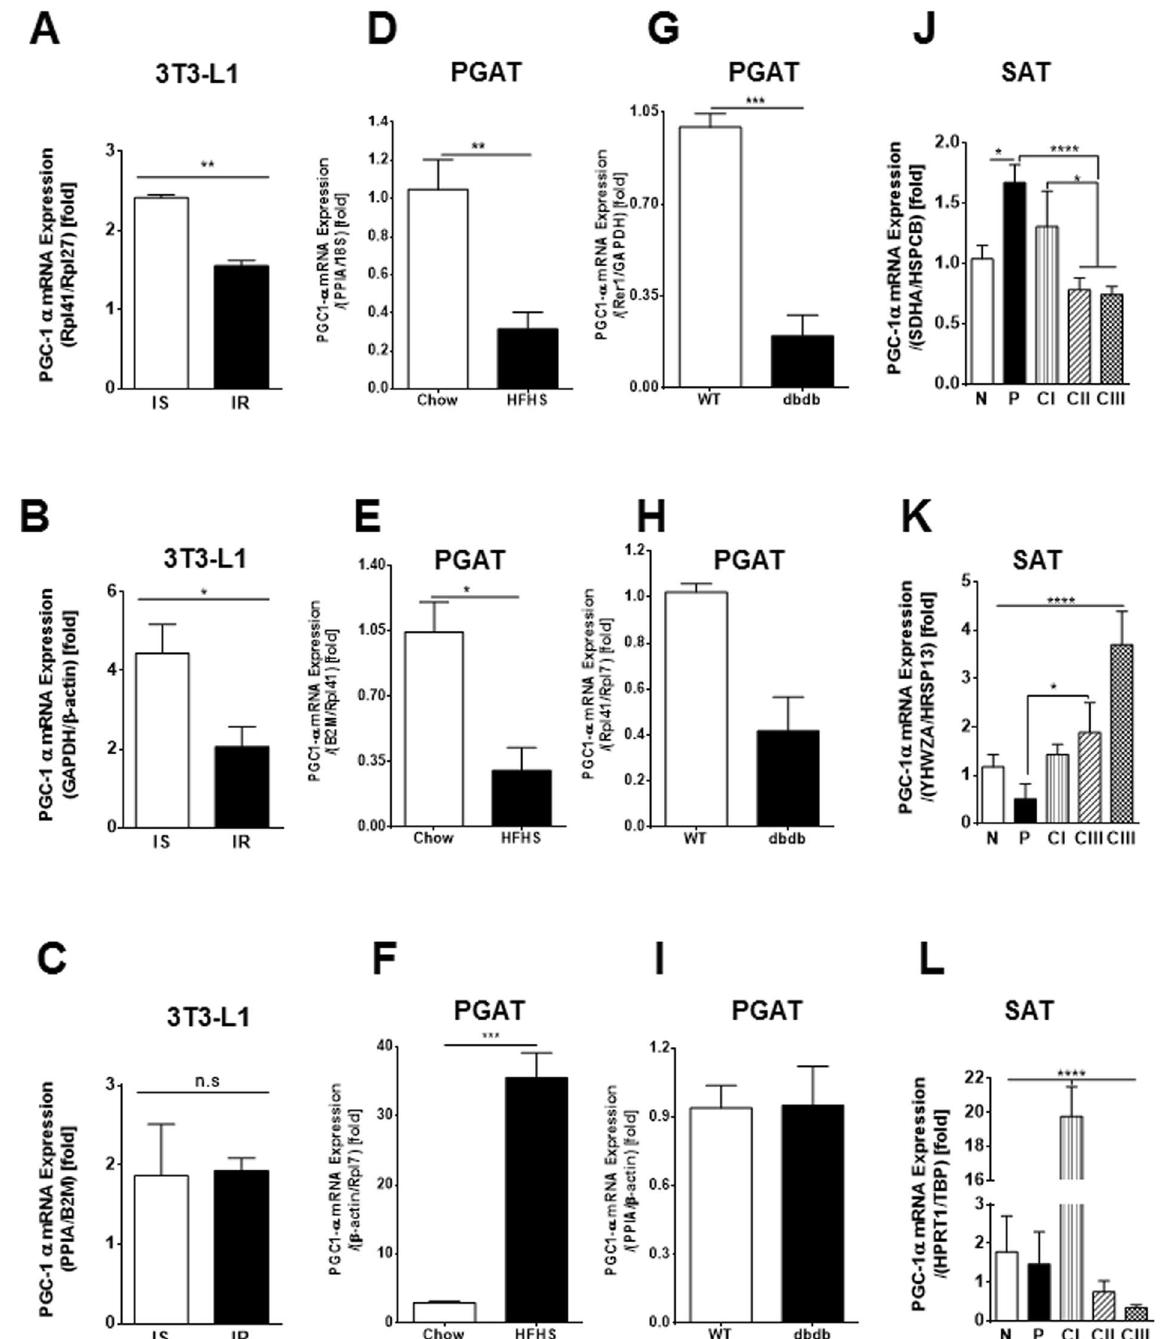
Figure 4. Expression levels of PGC1 α normalized to different reference genes (RGs). PGC1 α expression levels were analyzed using the best two RGs in combination ( A,D,G and J ), using two RGs with middle stability in combination ( B,E,H and K ), and using the two lowest ranked RGs in combination ( C,F,I and L ). ( A–C ) shows the comparison of RG choice for Pgc1 α expression in insulin sensitive (IS) and insulin resistant (IR) 3T3-L1 cells; comparisons of RG choice on Pgc1 α expression in PGAT from chow/HFHS-fed mice ( D–F ) and WT/ dbdb mice ( G–I ); ( J–L ) shows the comparison of RG choice for PGC1 α expression in SAT from non-obese ( N ), preobese ( P ) and obese class I (CI), II (CII) and III (CIII) patients. All data are presented as the relative expression levels and as mean ± SEM; statistical analysis was performed using a one-way ANOVA followed by a Tukey’s multiple comparison analysis: * p < 0.05, ** p < 0.01, *** p <